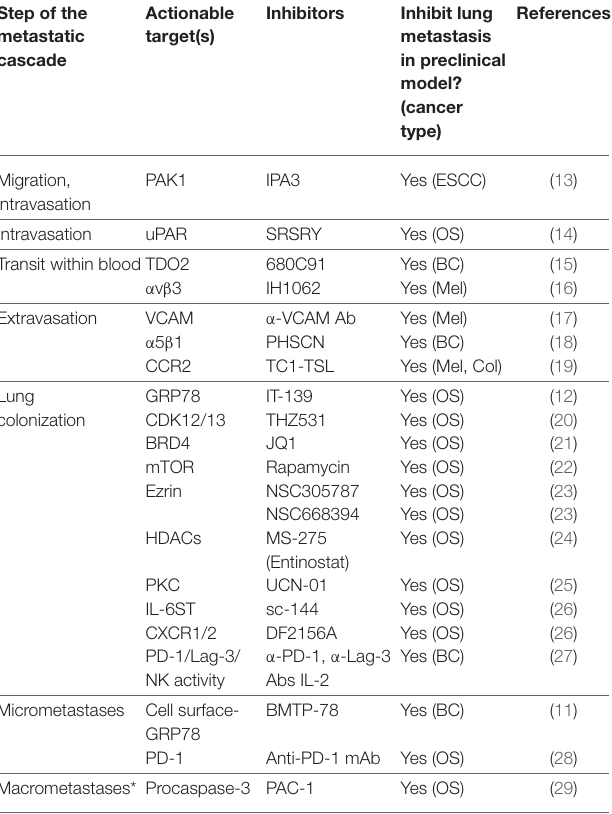
TABLE 2 | Druggable molecular targets in the metastatic